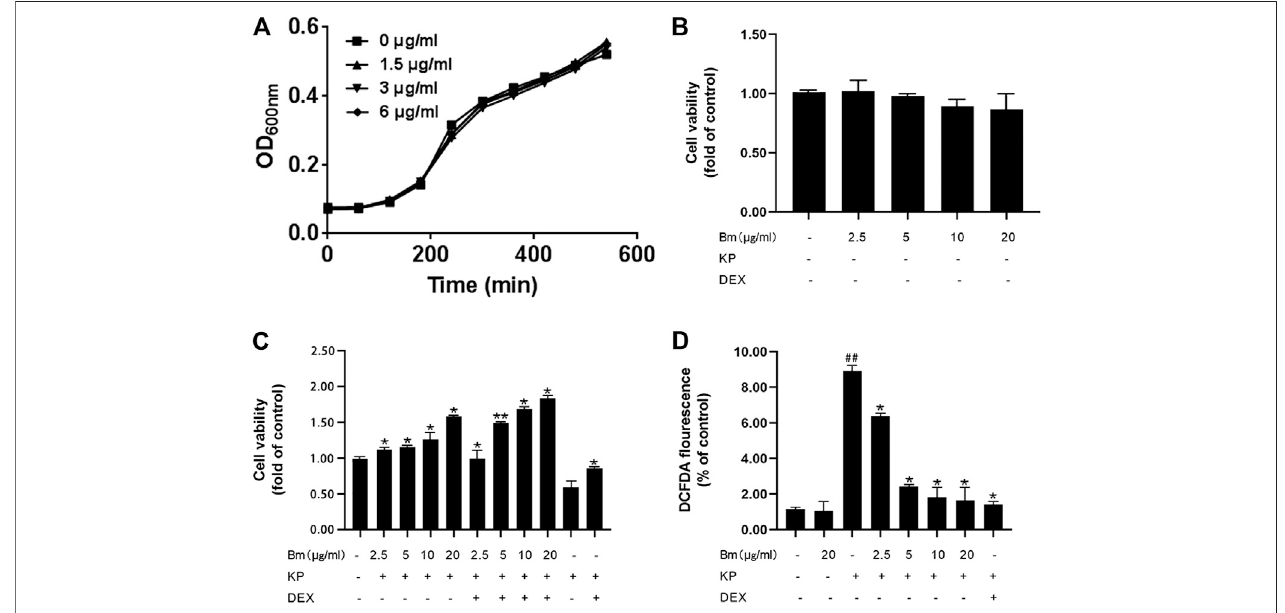
FIGURE 1 | Effect of Bergenin monohydrate on Klebsiella pneumonia -infected RAW264.7 cell viability and ROS production (A) Viable cell count growth curves (B) Cell viability without Klebsiella pneumonia infection (C) Cell viability with both Klebsiella pneumonia infection and Bergenin monohydrate protection (D) ROS production with both Klebsiella pneumonia infection and Bergenin monohydrate protection. All data are presented as the means ± SEM ( n (cid:2) 5). ## p < 0.01 vs the Control group; * p < 0.05 and ** p < 0.01 vs the Klebsiella pneumonia group.